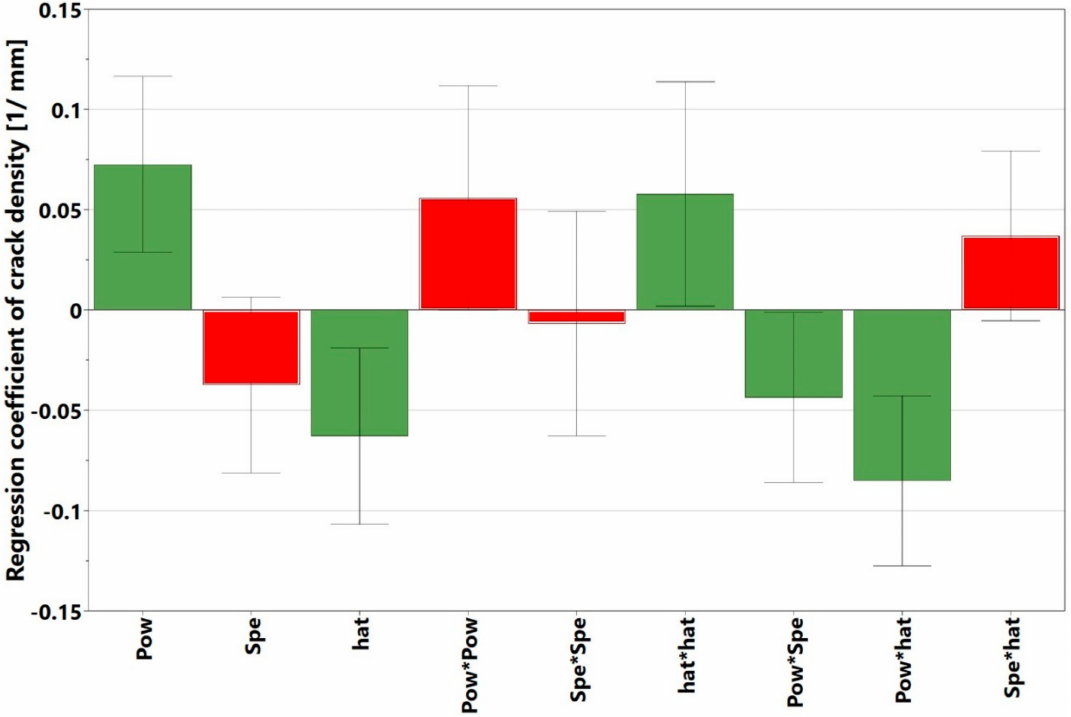
Figure 12. Regression coe ffi cients for di ff erent factors and interaction of factors a ff ecting the crack density (green bars indicate significant factors, while red bars indicate non-significant factors).